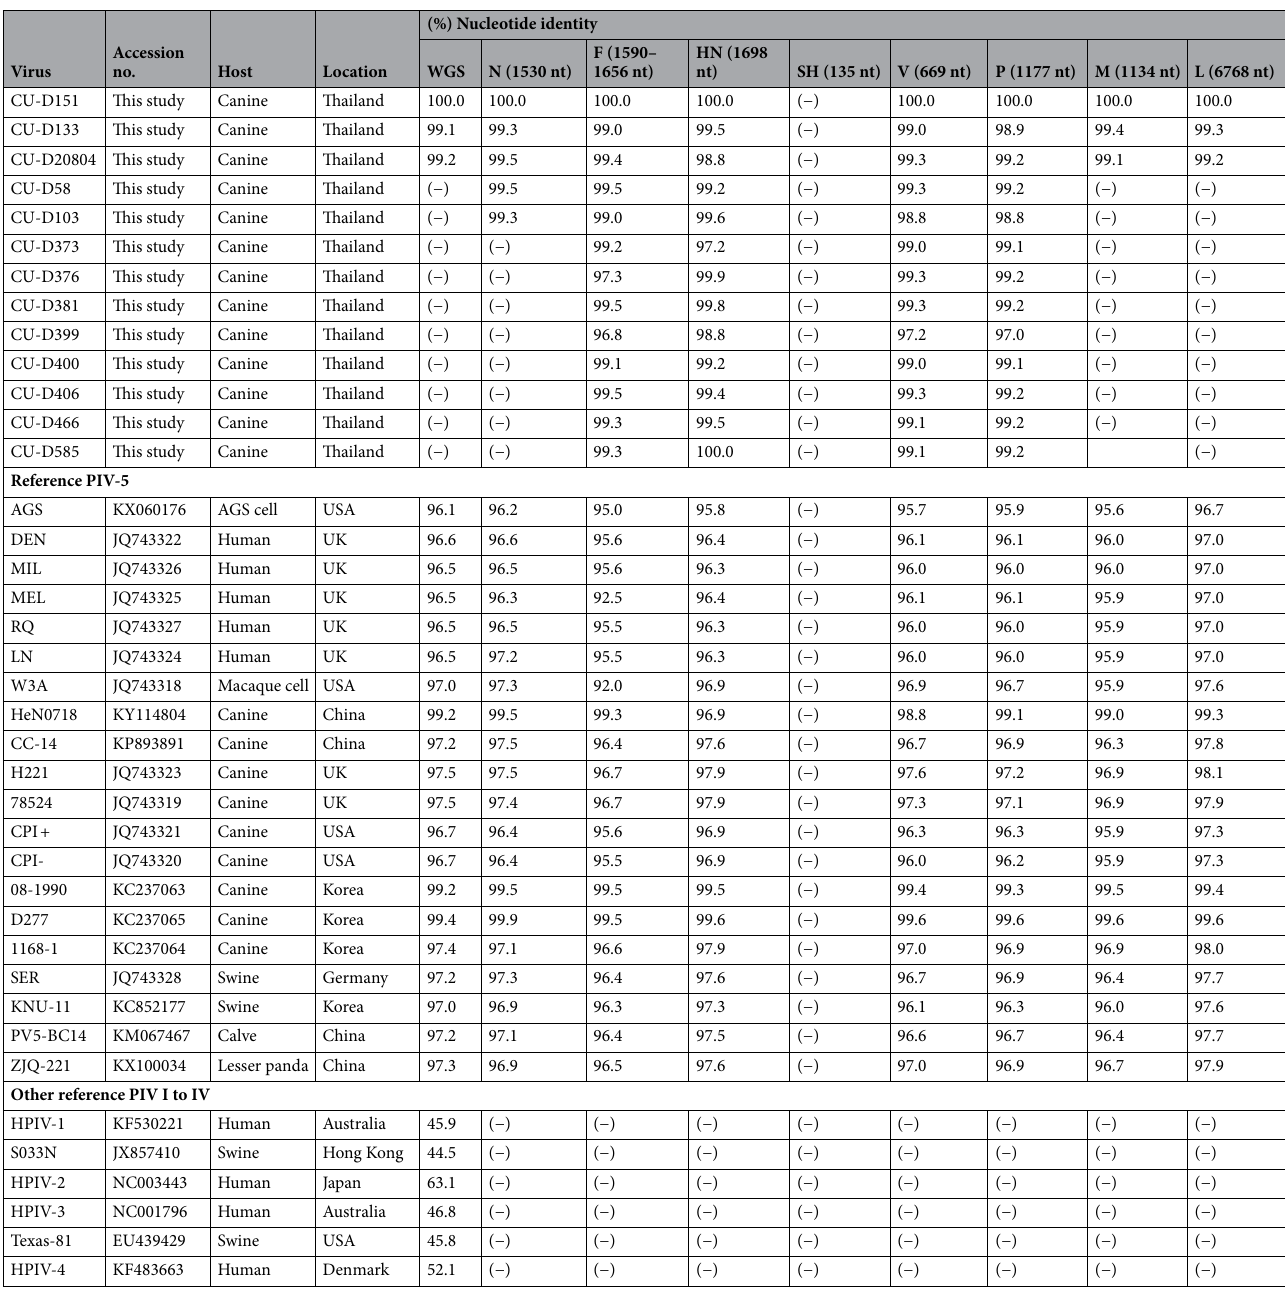
Table 2. Pairwise comparison of whole genome nucleotide sequences of Thai CPIV-5 (CU-D151) with reference parainfluenza